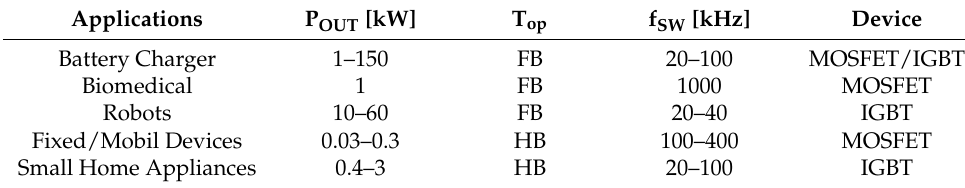
Table 1. Application areas, topologies and semiconductor power devices.